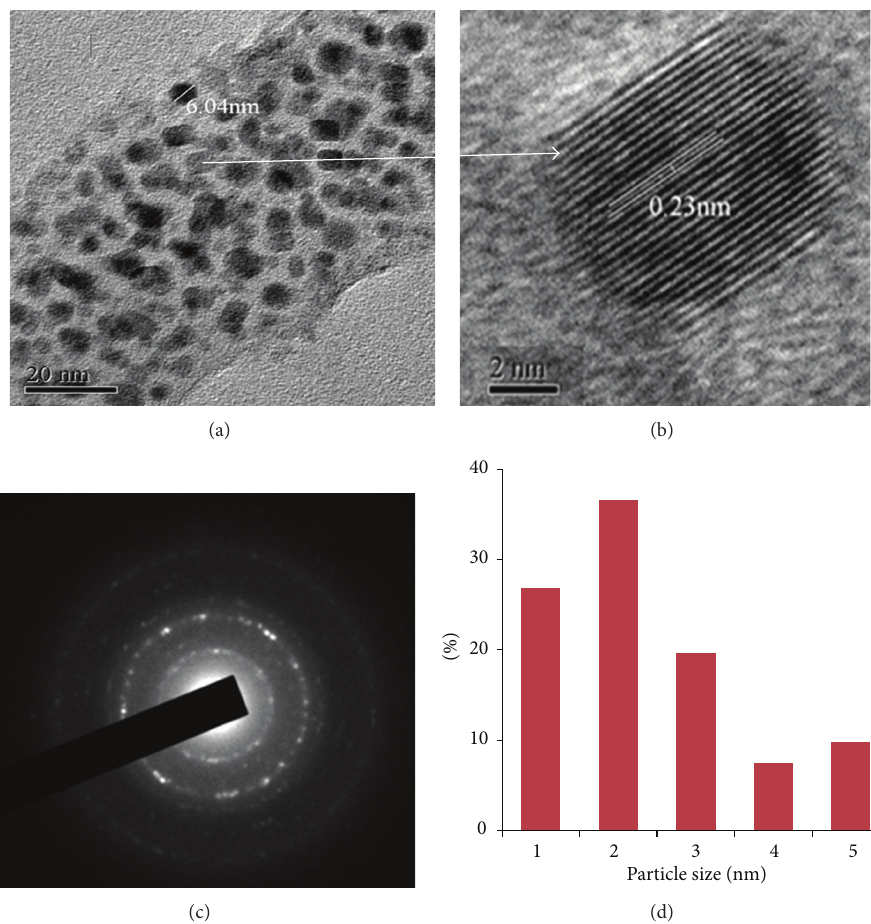
Figure 3: (a) TEM image of CdSe thin film (S4) prepared by thermolysis at 300 ∘ C. (b) HRTEM image of CdSe thin film (S4) prepared by thermolysis at 300 ∘ C. (c) SAED image of CdSe thin film (S4) prepared by thermolysis at 300 ∘ C. (d) Size distribution of CdSe